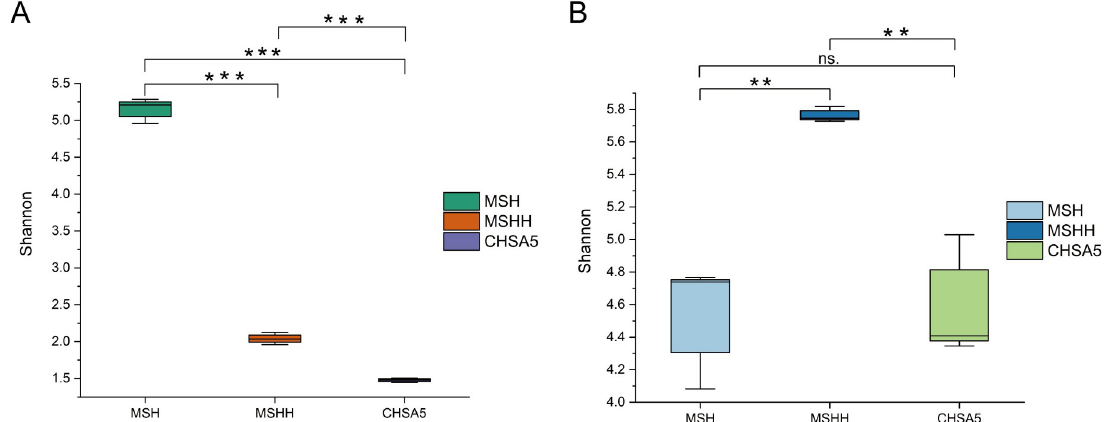
Fig 9. Shannon diversity indexes of phytoplankton (A) and zooplankton (B) in the test waters of MSH, MSHH, and CHSA5. MSH: the mosquito was living in the water from the Meishe river alone. MSHH: the mosquito was living in water from the Meishe river supplemented with wild Chlorella HOC5. CHSA5: the mosquito was living in water from the Meishe river supplemented with recombinant Chlorella CHSA5.